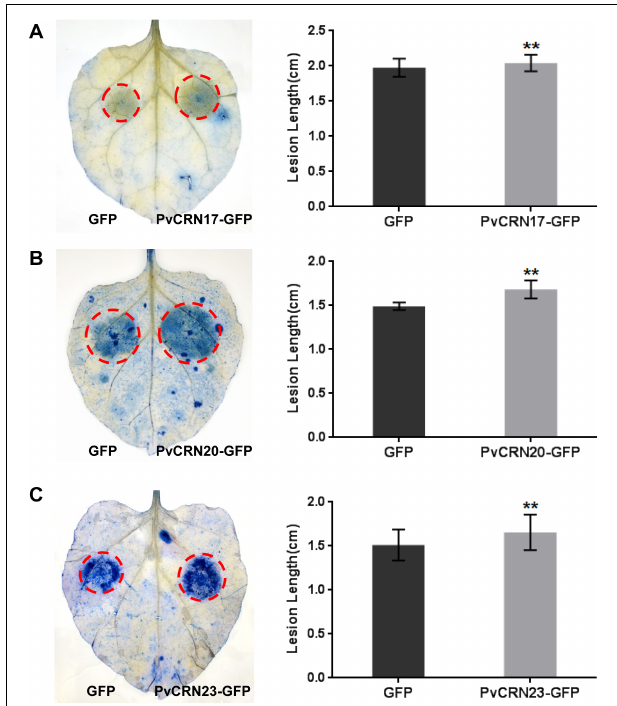
FIGURE 6 | Transient expression of PvCRN17 , PvCRN20 and PvCRN23 in N. benthamiana leaves promoted P. capsici colonization. (A–C) indicate the results for PvCRN17 , PvCRN20 , and PvCRN23 , respectively. Left panel : representative inoculated N. benthamiana leaves stained with trypan blue. The lesions are outlined with red circles. Right panel : mean lesion lengths of N. benthamiana leaf regions in which each PvCRN or the control GFP were expressed. The heights of rectangles represent the mean lesion lengths. Error bars represent SD of 9–12 samples. Asterisks indicate significant differences from the control groups (paired t -test; ** p < 0.01). Similar results were obtained from at least three independent experiments.